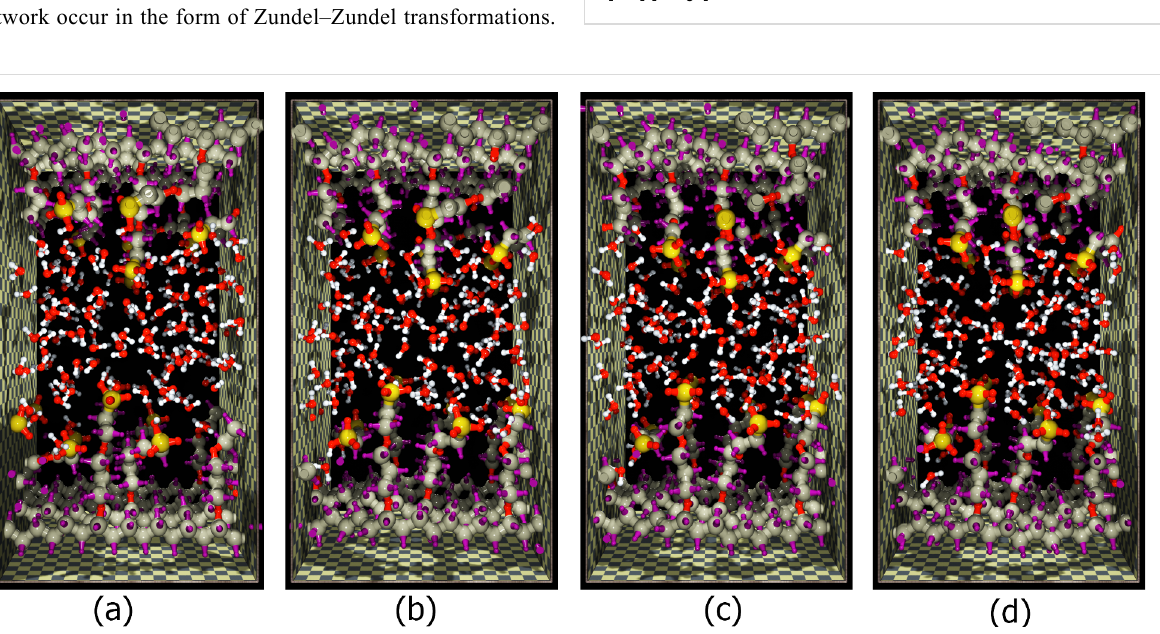
Figure 13: Sequence of snapshots from the QMD simulation of the ion-conducting nanochannel at different time points, starting with the initial con- figuration (a).